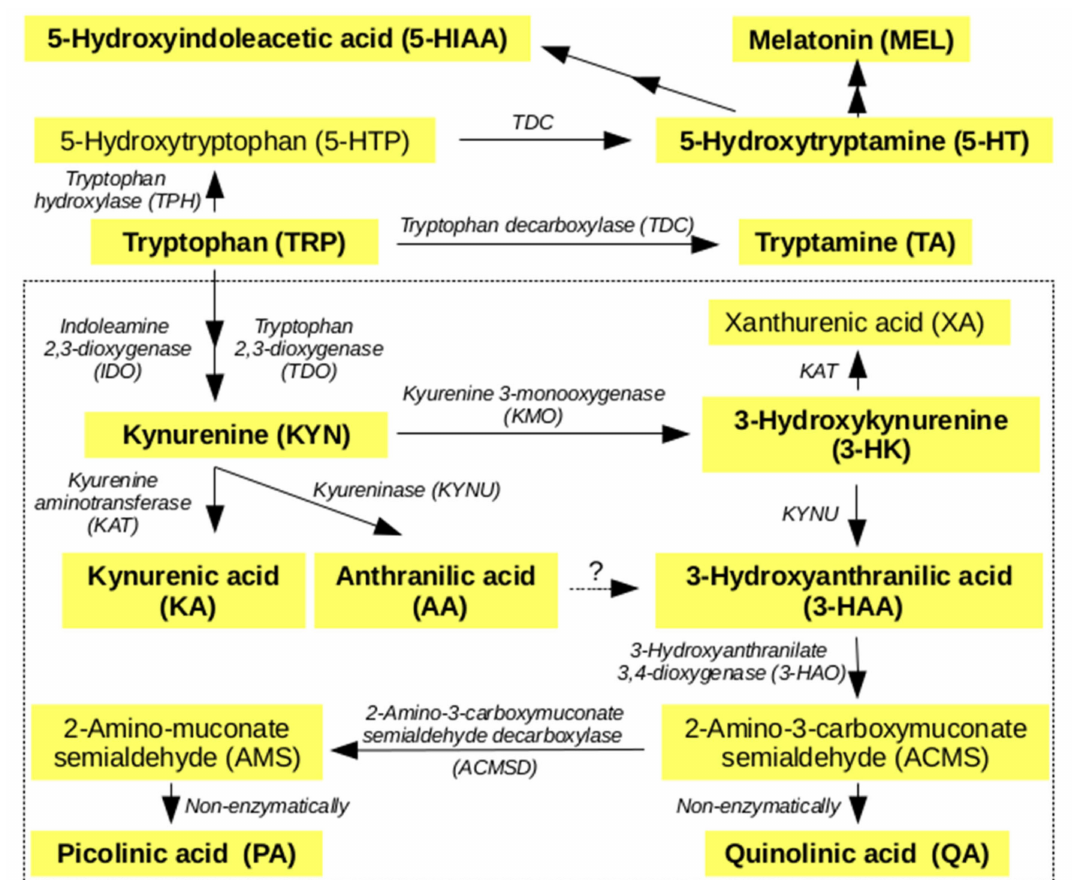
Figure 1. Simpified major metabolic pathways of tryptophan (TRP) in humans. Metabolites marked in bold were quantified by liquid chromatography–tandem mass spectrometry (LC-MS / MS) in the current study. The area enclosed by the dotted line indicates kynurenine pathway